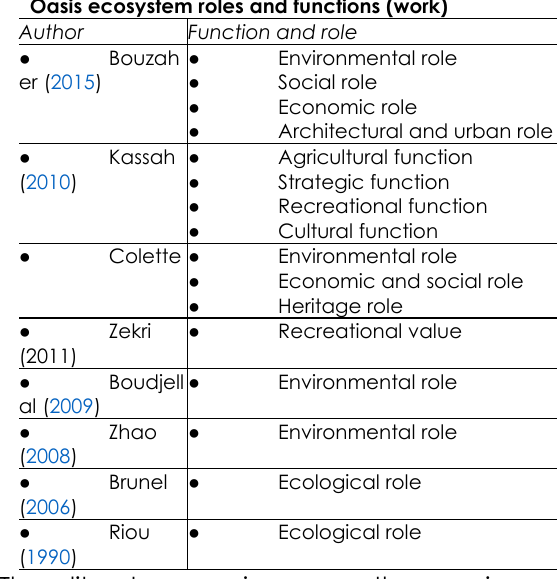
Table 1. Example of works dealing with the functions and roles of the oasis. Oasis ecosystem roles and functions